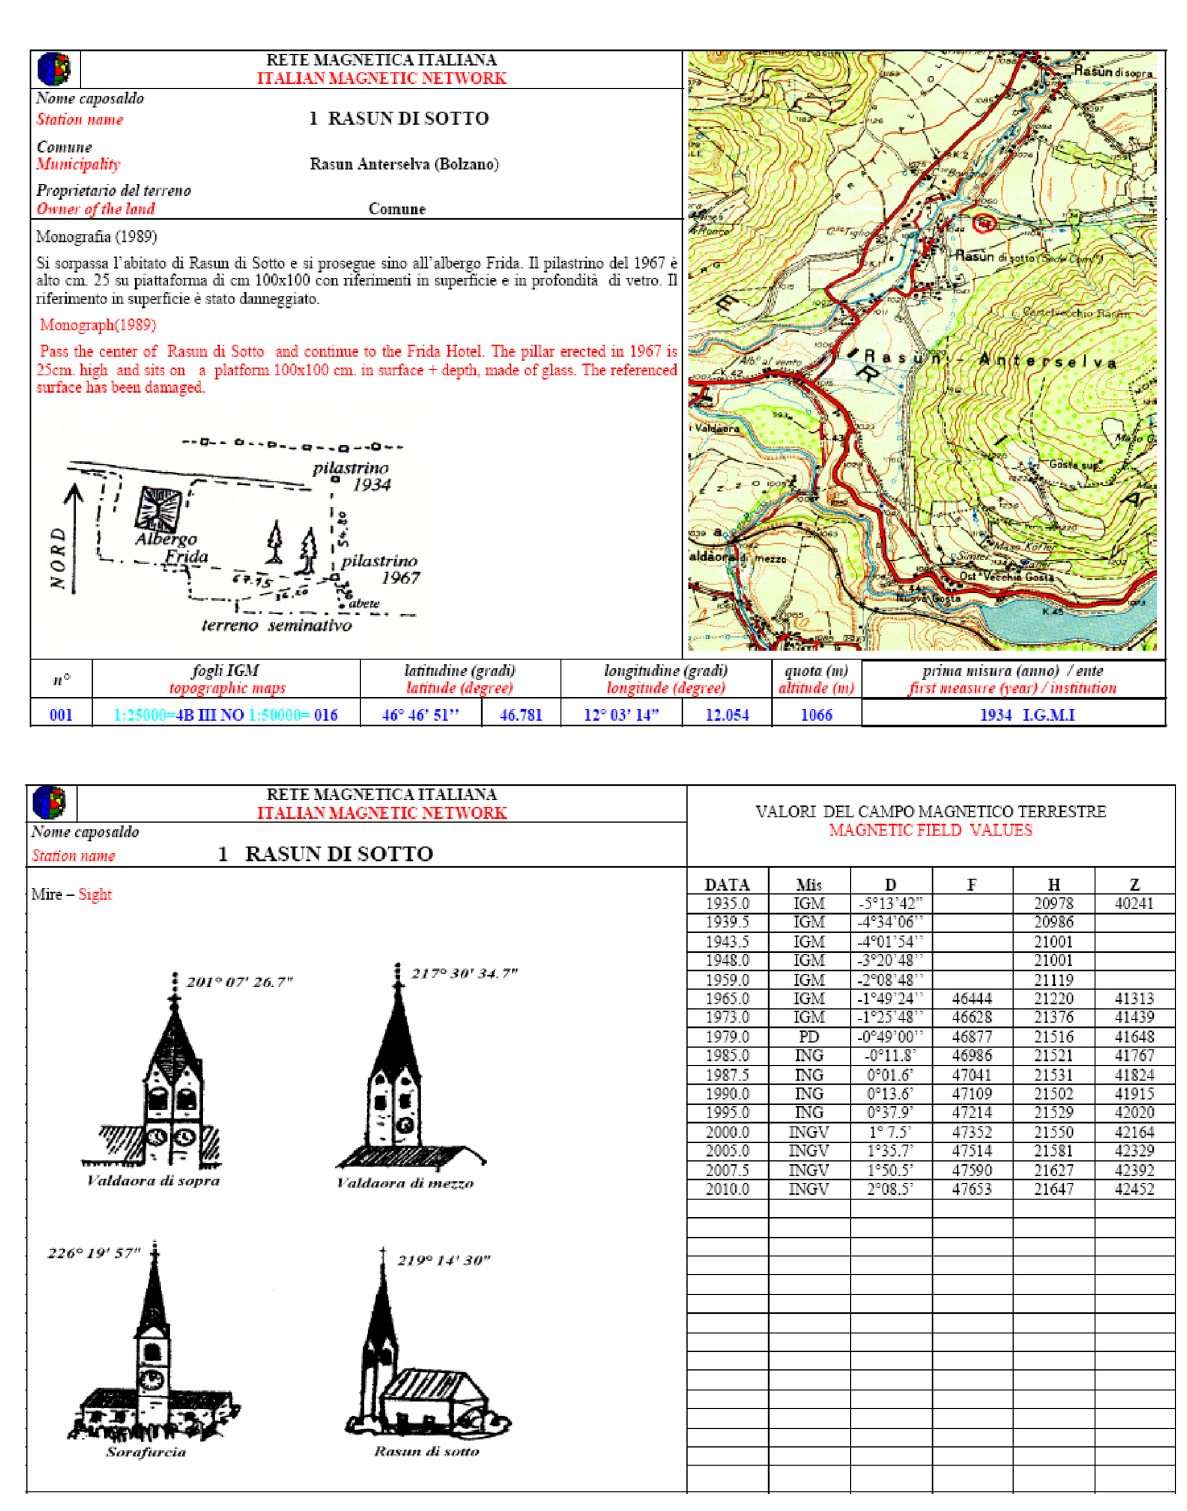
Figure 2. Example of a repeat station monograph, prepared for the purpose of keeping note of the magnetic measurements, and to allow a quick determination of the correct